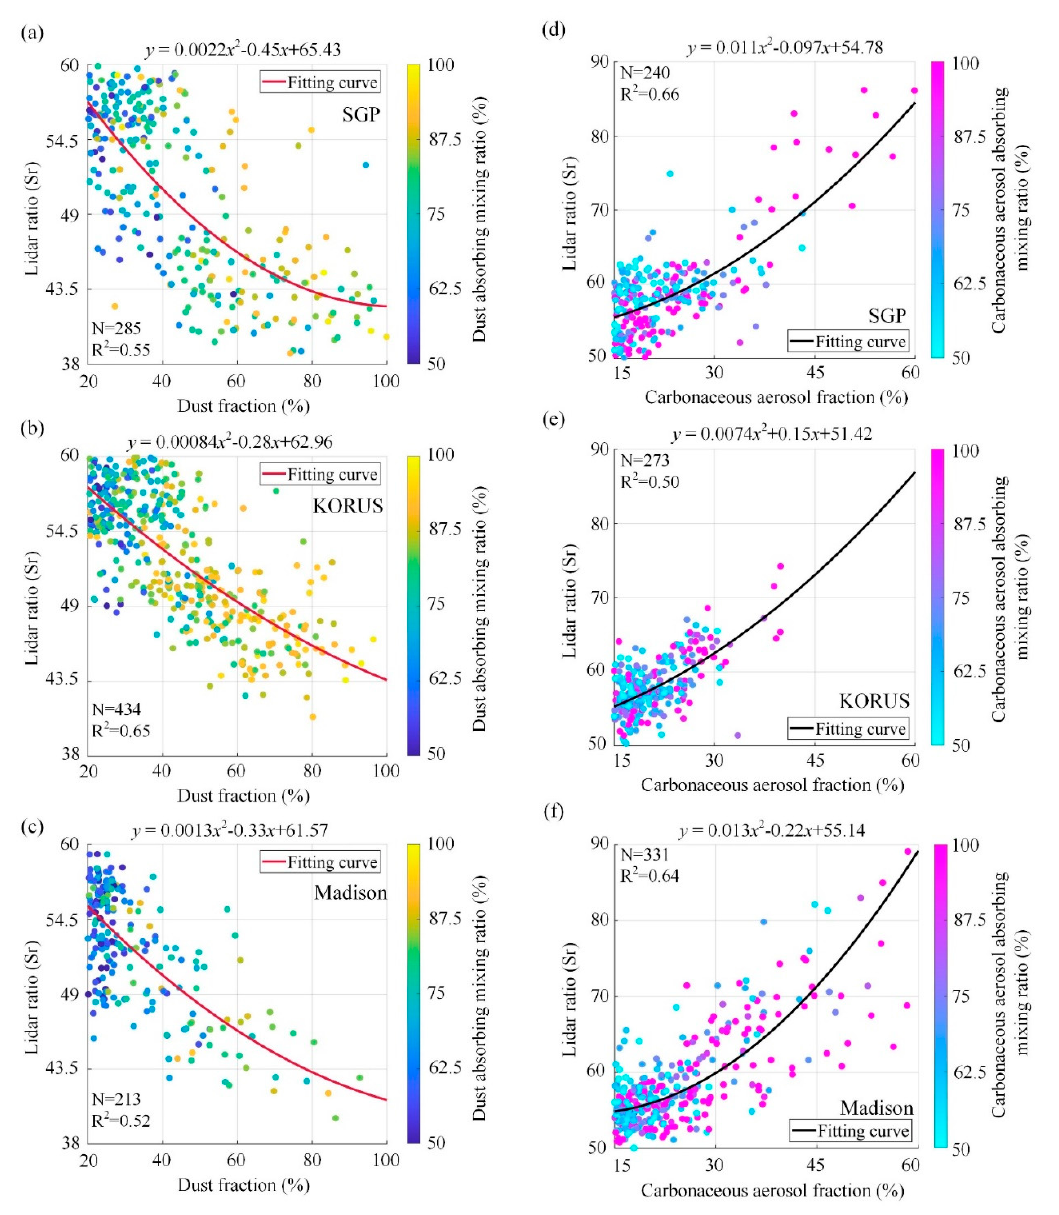
Figure 5. Scatter plot of the absorbing aerosol lidar ratio retrieved by HSRL and fraction retrieval by the sun photometer. N and R 2 represent the number of fitting points and coefficient of determination, respectively. ( a – c ) represent the fitting relationship of the lidar ratio and dust fraction at the SGP, KORUS, and Madison sites, respectively. The solid red line represents the fitting results, and the color bar represents the dust absorbing mixing ratio; ( d – f ) represent the fitting relationship of the lidar ratio and carbonaceous aerosol fraction at the SGP, KORUS, and Madison site, respectively. The solid black line represents the fitting results, and the color bar represents the carbonaceous aerosol absorbing mixing ratio. The top of the subplot represents the equation of the fitted curve .